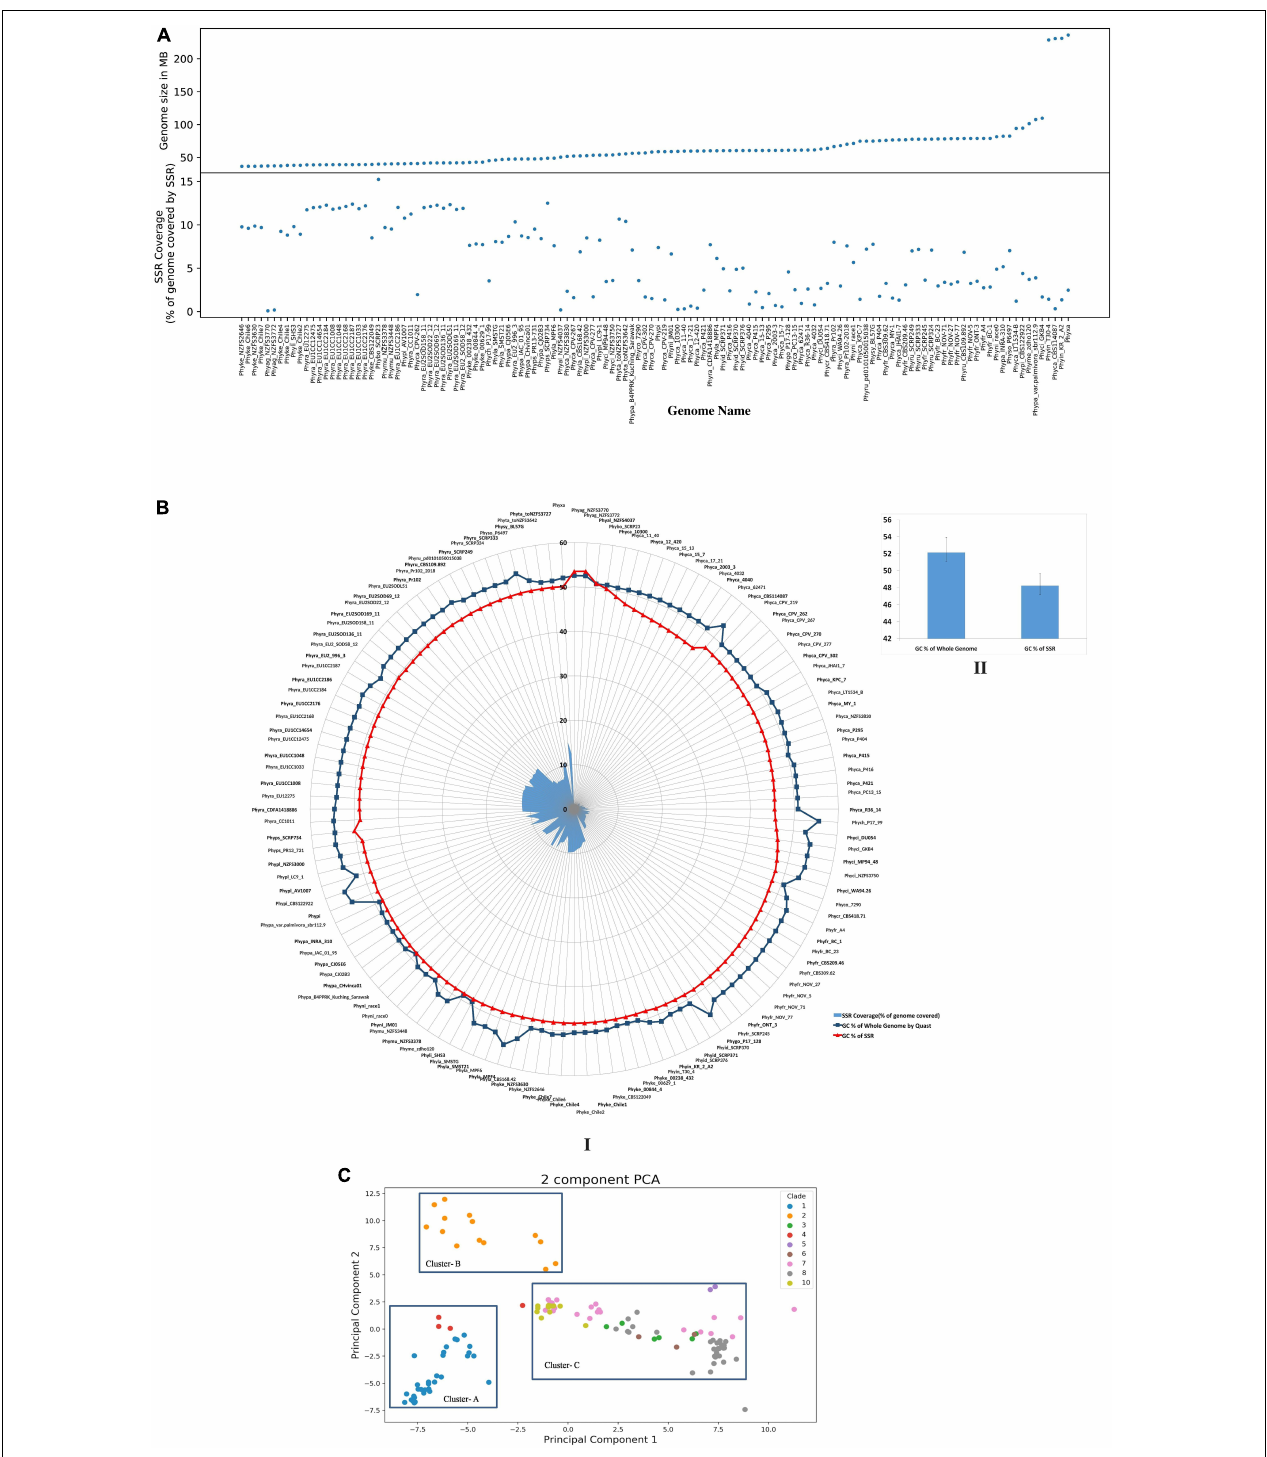
FIGURE 1 | Comparison of various SSR attributes within genomes. (A) Comparison of genome size and SSR coverage. (B) GC content of SSRs and their corresponding genomes. Genomic GC content of Phytophthora (52.13 ± 1.18%) and GC content of SSRs is (48.22 ± 1.5%). I: Is the circular representation of GC content. II: Represents the bar plots of mean genome GC content and SSR GC content. (C) PCA clustering using SSR motifs. Each dot represents a genome and is colored based on their clades as described in Yang et al. (2017). Di, tri, and tetramer motifs were taken from each genome, and PCA was done. Genomes from each clade clusters together more than others indicate phylogeny-based SSR variation. Cluster-A contains genomes from clade 1 and 4. Clade 2 positioned separately as Cluster-B. The rest of the genomes from clades 3, 5, 6, 7, 8, and 10 are clustered together as Cluster-C.